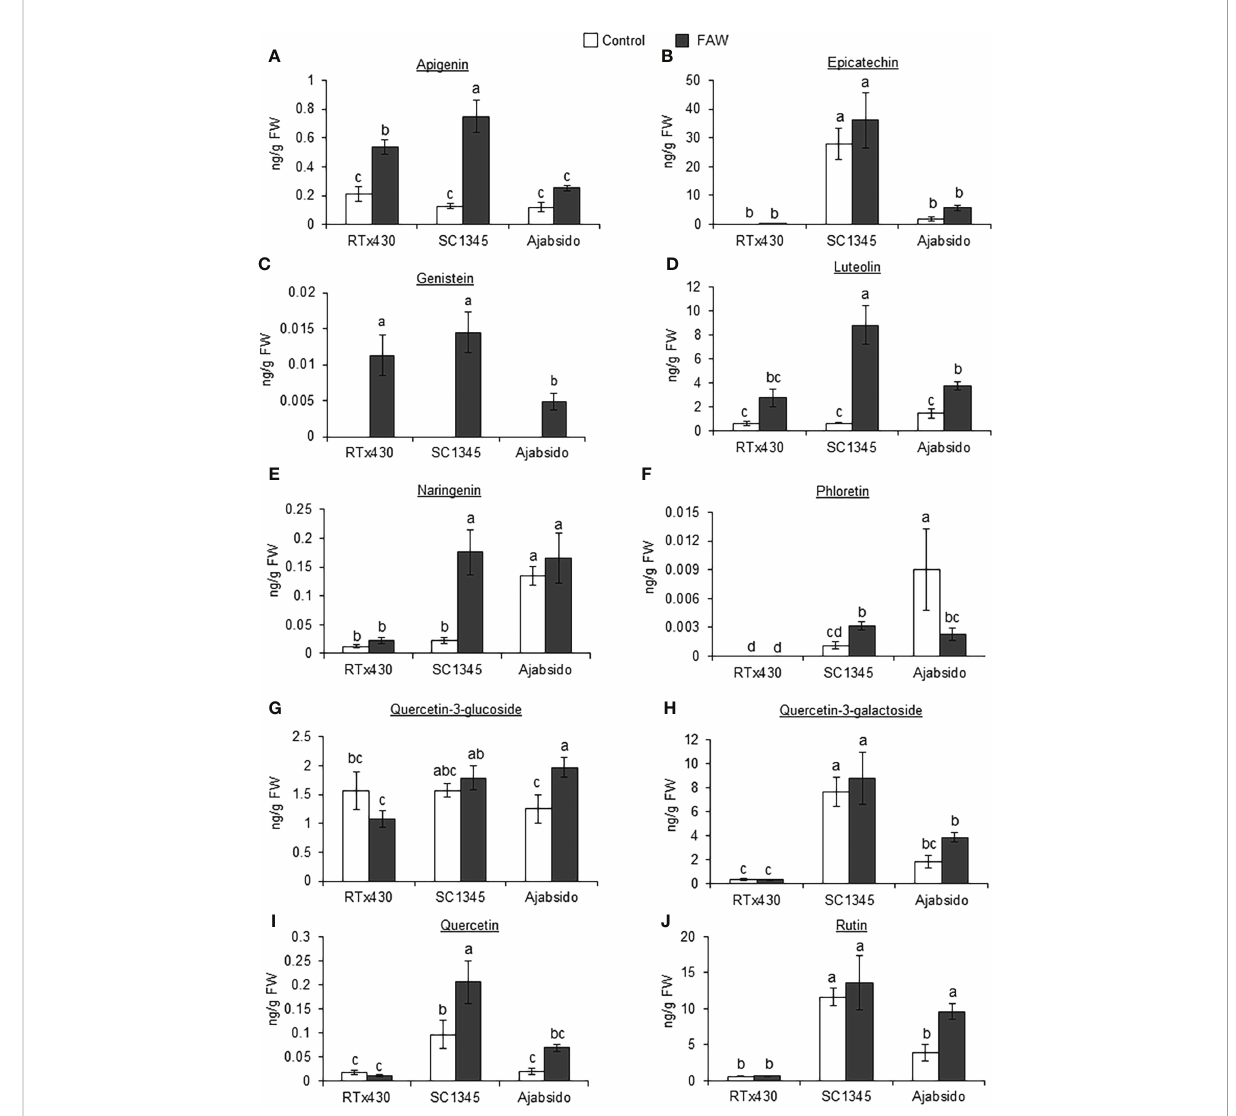
FIGURE 5 Fall armyworm (FAW) infestation enhanced the levels of several fl avonoid compounds in SC1345 plants. Absolute abundances of fl avonoid compounds, (A) Apigenin, (B) Epicatechin, (C) Genistein, (D) Luteolin, (E) Naringenin, (F) Phloretin, (G) Quercetin-3-glucoside, (H) Quercetin-3- galactoside, (I) Quercetin, and (J) Rutin, in RTx430, SC1345, and Ajabsido plants before and after FAW infestation for 10 days (n = 3-4). FW, fresh weight. Error bars represent ± SE. Different letters indicate signi fi cant difference relative to each other ( P <